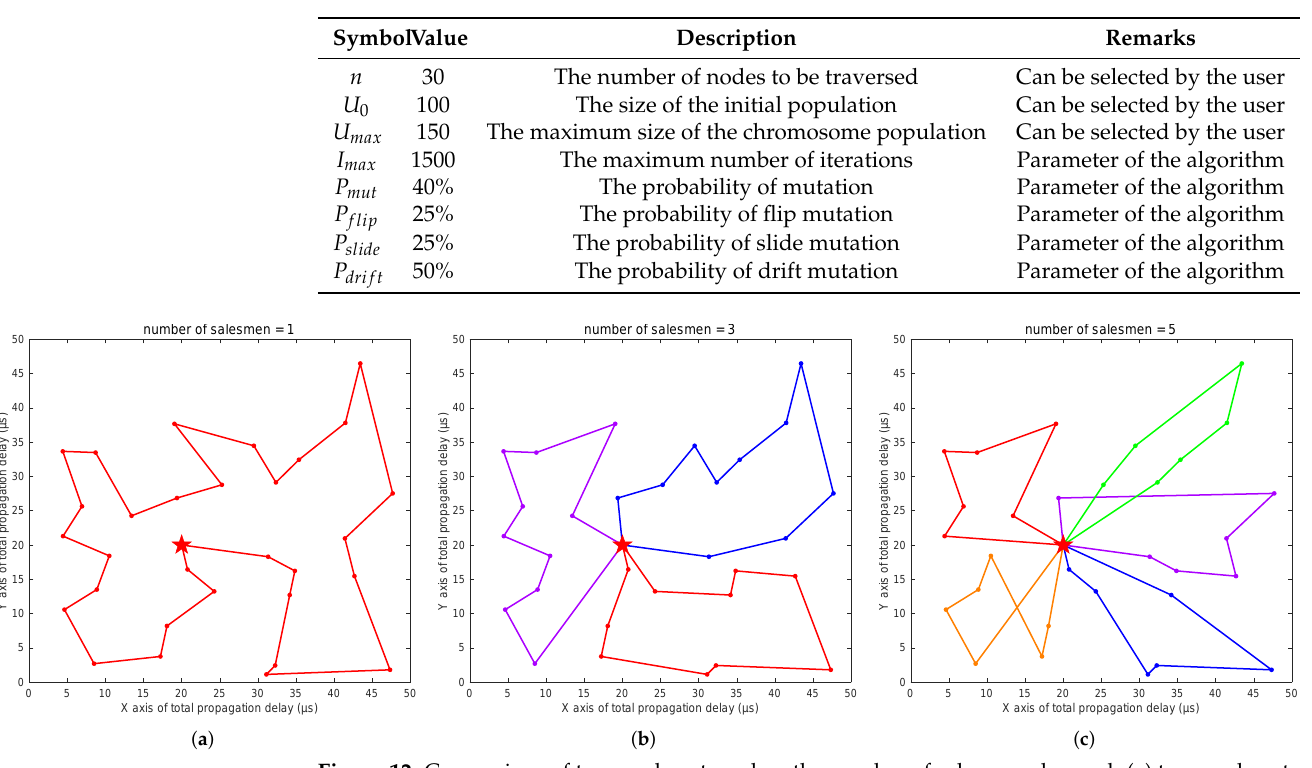
Table 2. TT flow routing simulation parameters.